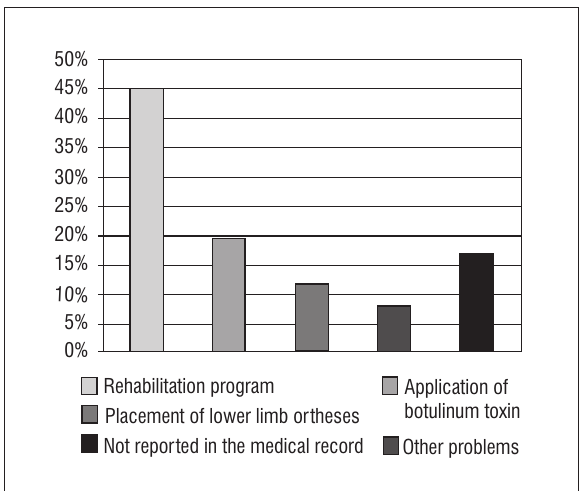
Figure 2 - Reasons for seeking care